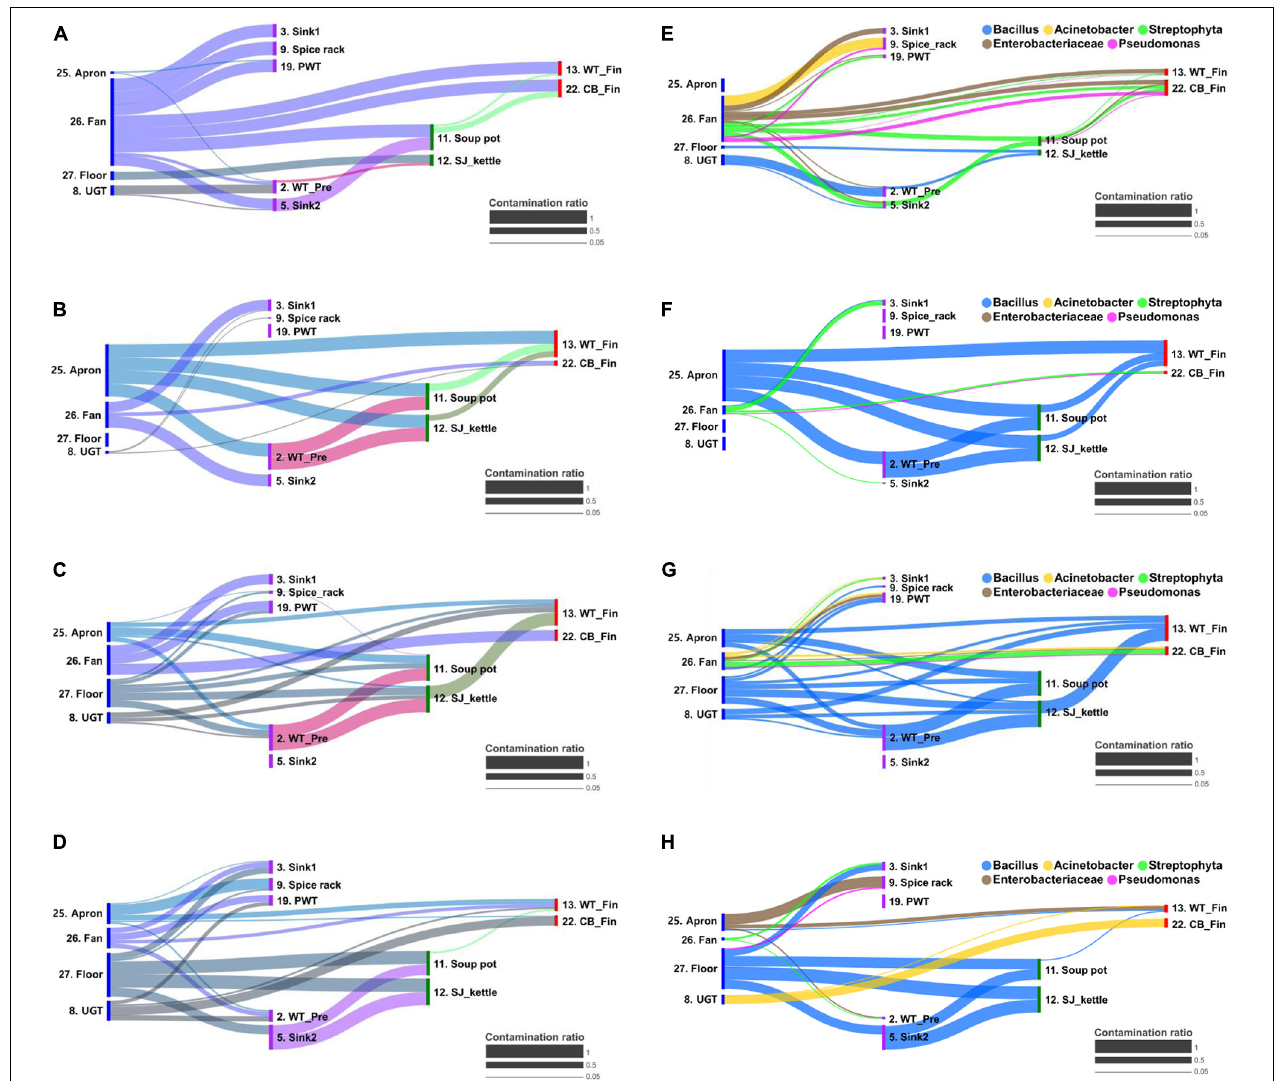
FIGURE 5 | Bacterial transfer during food preparation represented by contamination ratio. The contamination ratio of overall bacteria (A–D) and five major bacterial genus (E–H) at quarter 1 (A,E) , 2 (B,F) , 3 (C,G) , and 4 (D,H) . The contamination ratio was calculated using the Bayesian-based SourceTracker based on the similarity of the microbial distribution between surfaces. CB_Fin, cutting board for final preparation; PWT, plastic wicker tray; SJ_kettle, steam-jacketed kettle; UGT, undershelf of the grill table; WT-Fin, worktable for final preparation; WT_Pre, worktable for